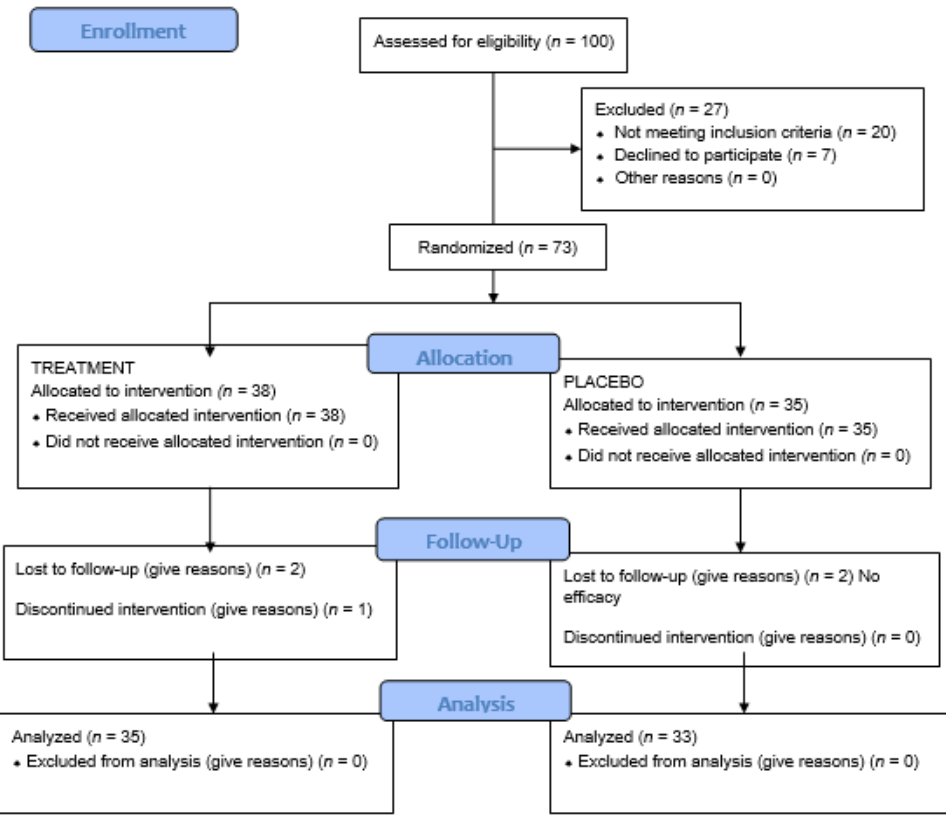
Figure 1. Flow diagram.